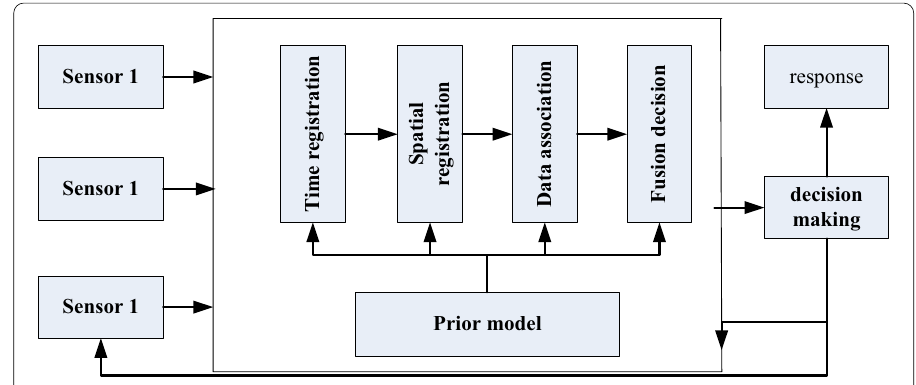
Fig. 3 Process diagram of information